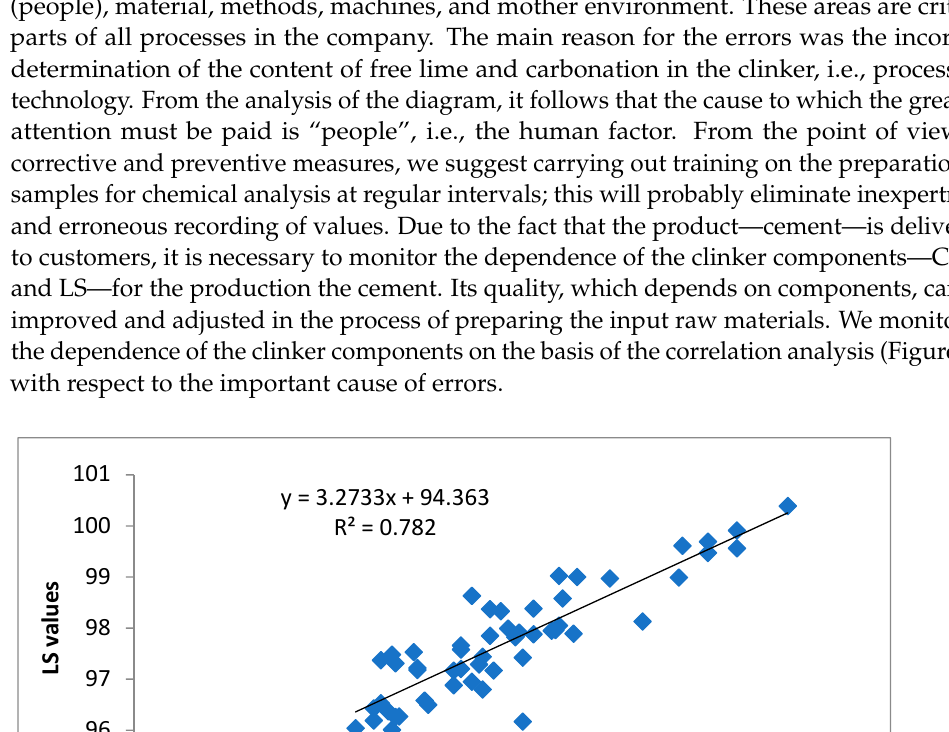
Figure 10. Ishikawa diagram for failures in clinker. Source: own source.